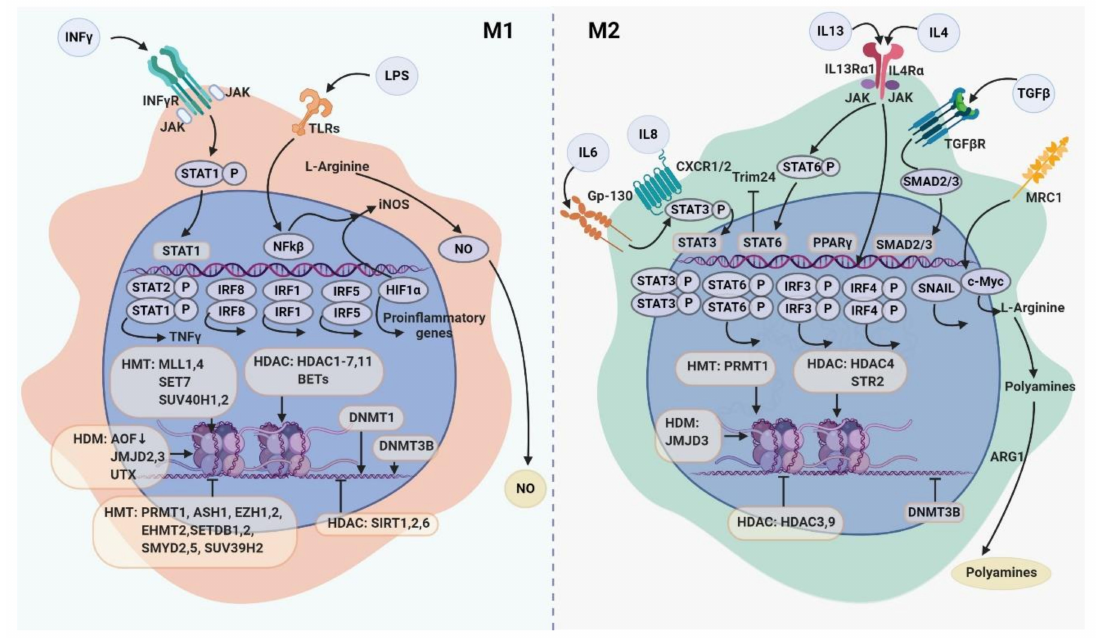
Figure 1. Transcription factors and epigenetic enzymes involved in macrophage polarization. ARG1—Arginase 1; HDAC—Histone deacetylase; HDM—Histone demethylase; HMT—Histone methyltransferase; P—phosphorylated form. Figure created in biorender (http: //